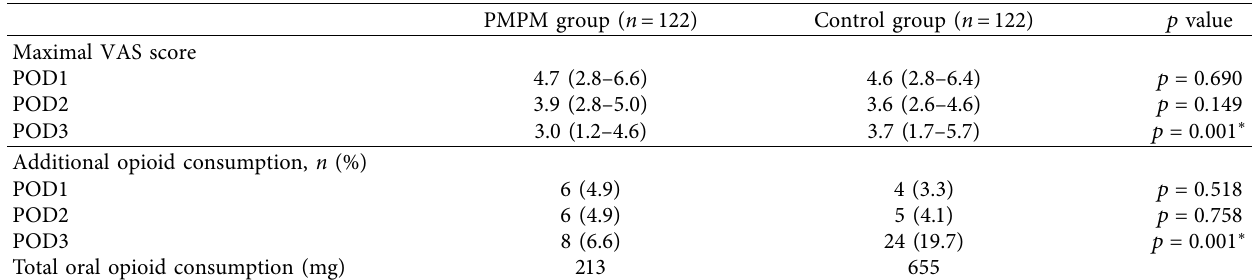
Figure 2: Percentages of patients receiving additional oral opioids on POD1, POD2, and POD3 for the PMPM group and control Table 3: Postoperative pain level and opioid consumption.